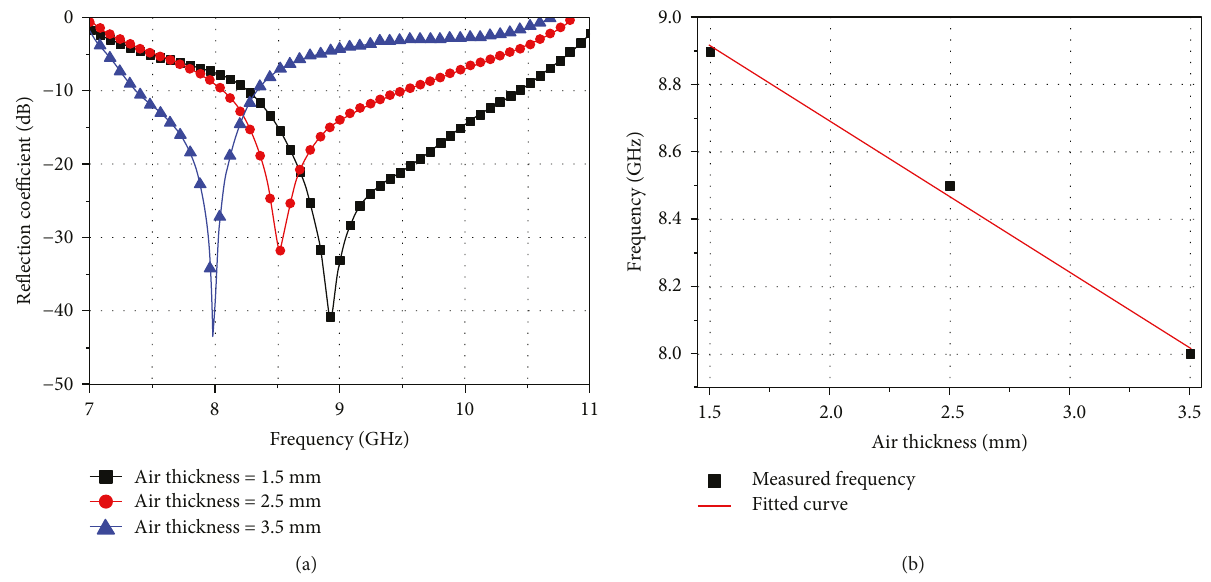
Figure 6: Measured re fl ection coe ffi cient according to change in air thickness and the relation between the measurement results and fi tted Table 1: Comparison of the proposed mechanically frequency recon fi gurable absorber with those of other papers. Reference paper